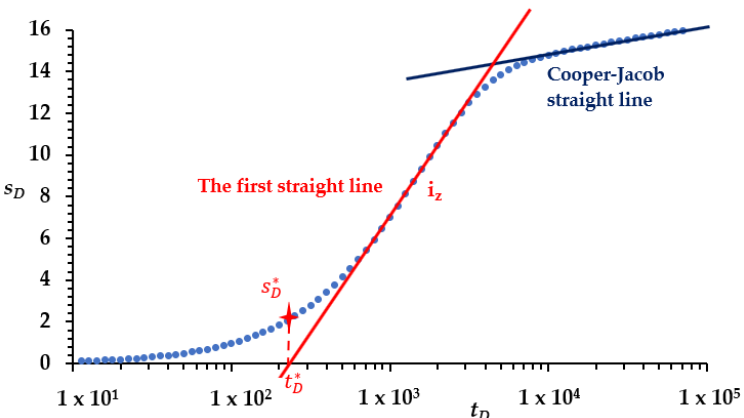
Figure 5. Semilogarithmic graph s D vs. log t D with two straight lines.